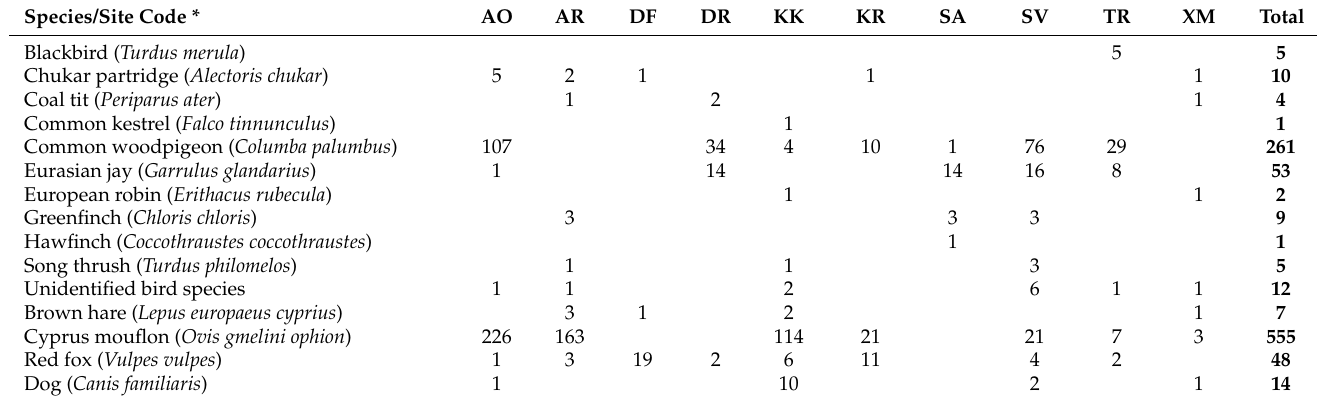
Table 2. Number of camera trap photographs recorded per water trough site and species (dotted line separates birds from